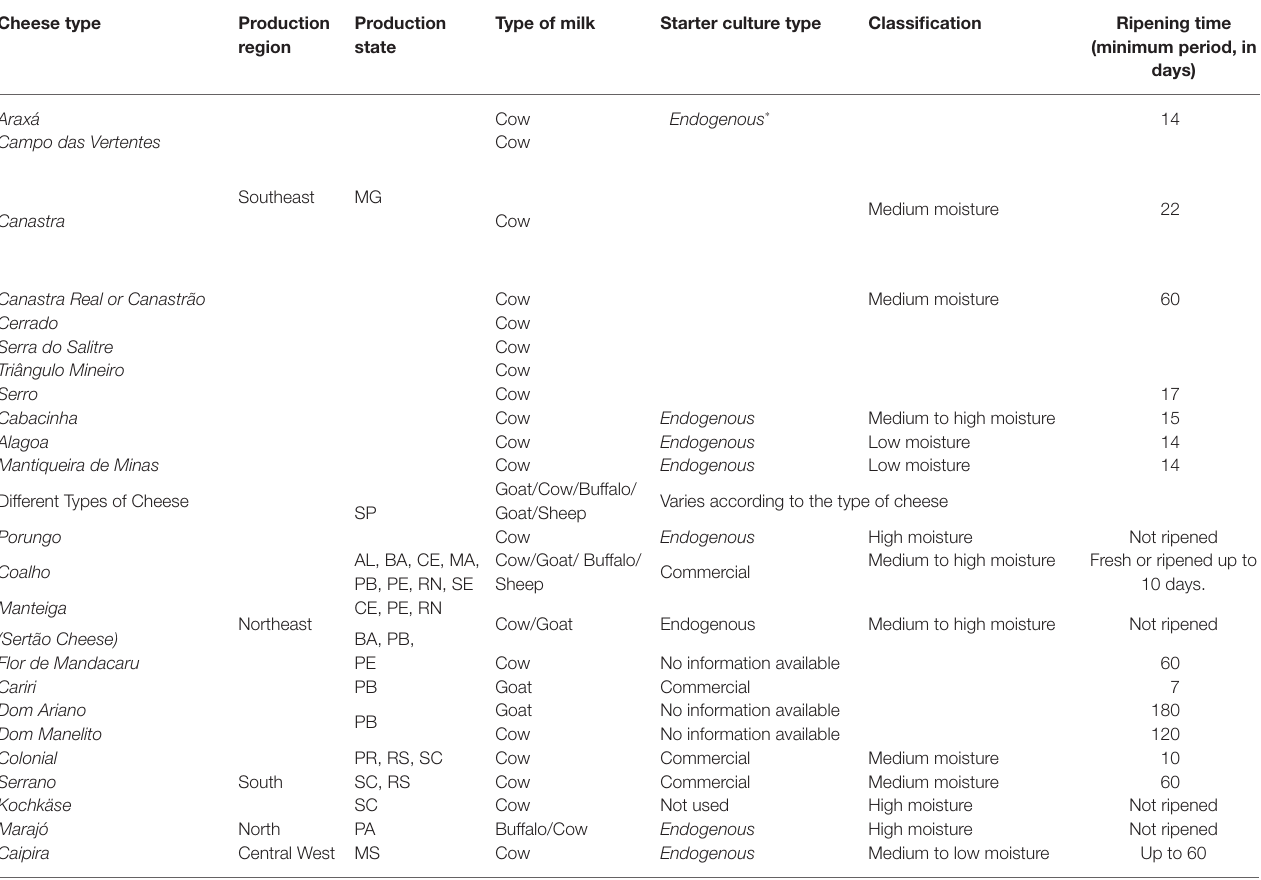
TABLE 1 | Types of Brazilian artisanal cheeses. Cheese